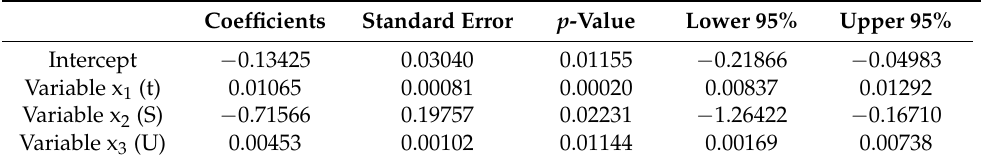
Table 3. ANOVA analysis for the coefficients of Equation